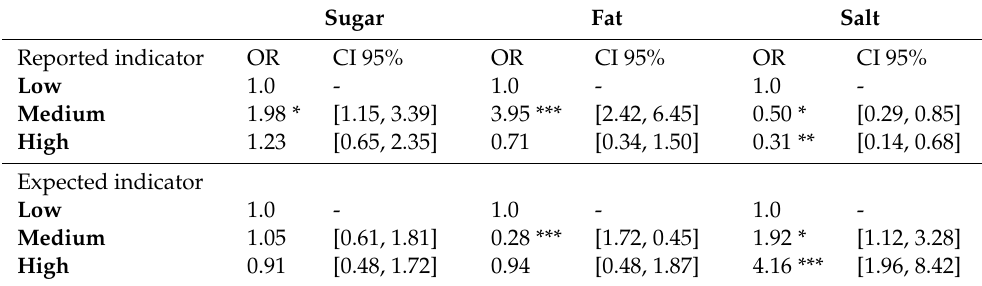
Table 6. Odds ratio for having inconsistencies by type of TL indicator reported on the label (n =